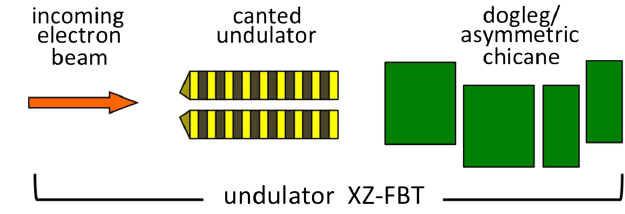
FIG. 14. More modern concept of the Bovet/Peterson emittance reduction technique. Reference [36] used this configuration to develop a scheme to transfer excess transverse emittance into the longitudinal direction both to reduce the transverse emittances and to provide a substitute for the laser heater for the LCLS accelerator. The image is from